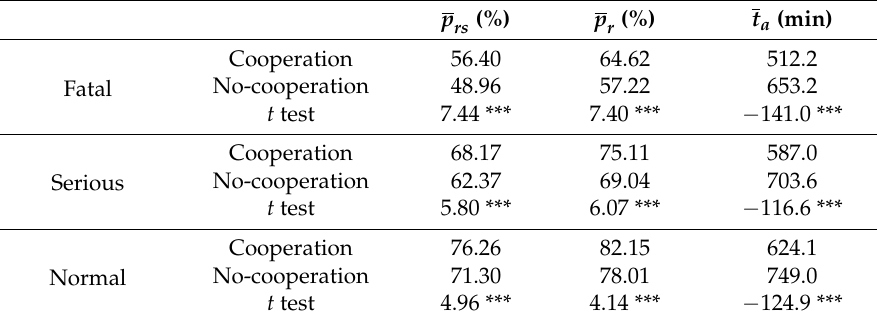
Table 4. The comparison of simulation results in three scenarios.